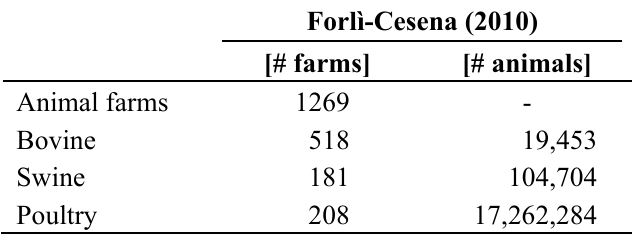
Table 2. Number of animal farms and their consistency in Forlì-Cesena